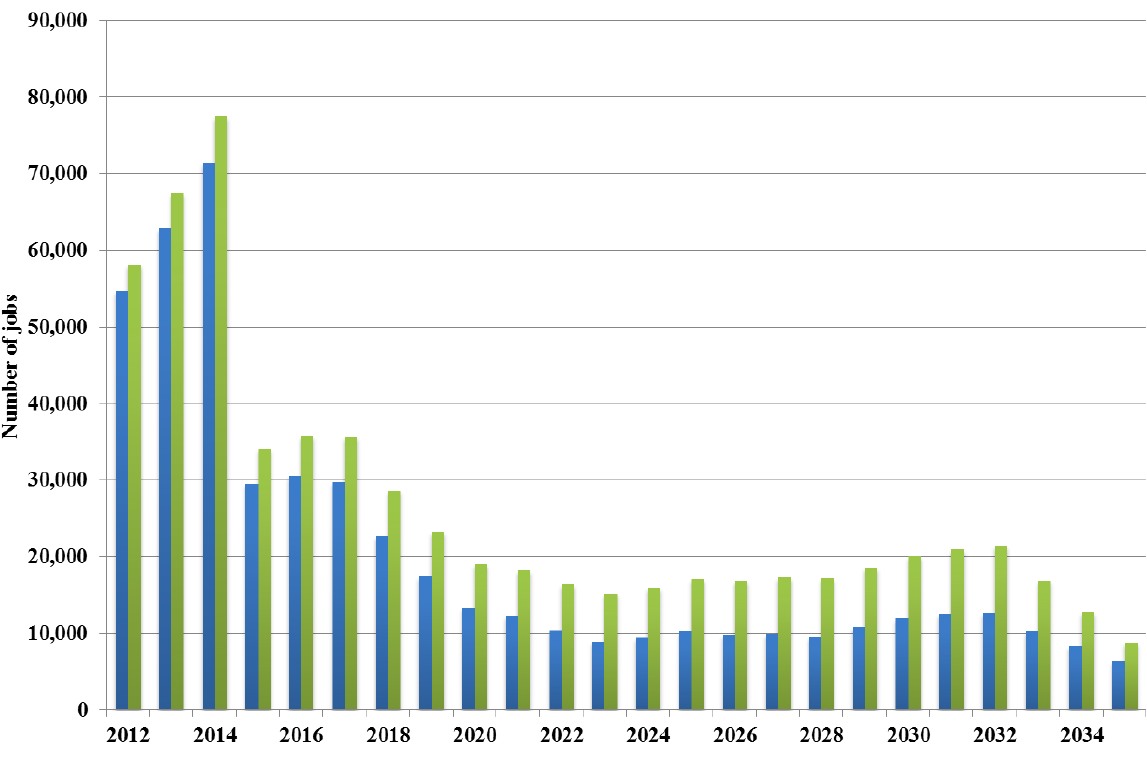
Figure 13. Gross employment gains under RPS